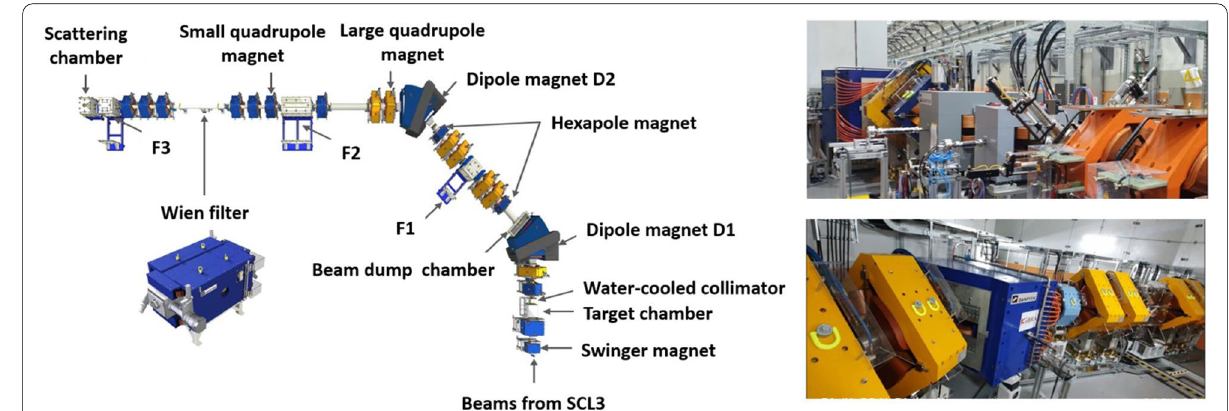
Fig. 12 Schematic of KoBRA on the left. The two images on the right show the production-target-chamber (F0) area (top) and the dispersive-focus (F1) area